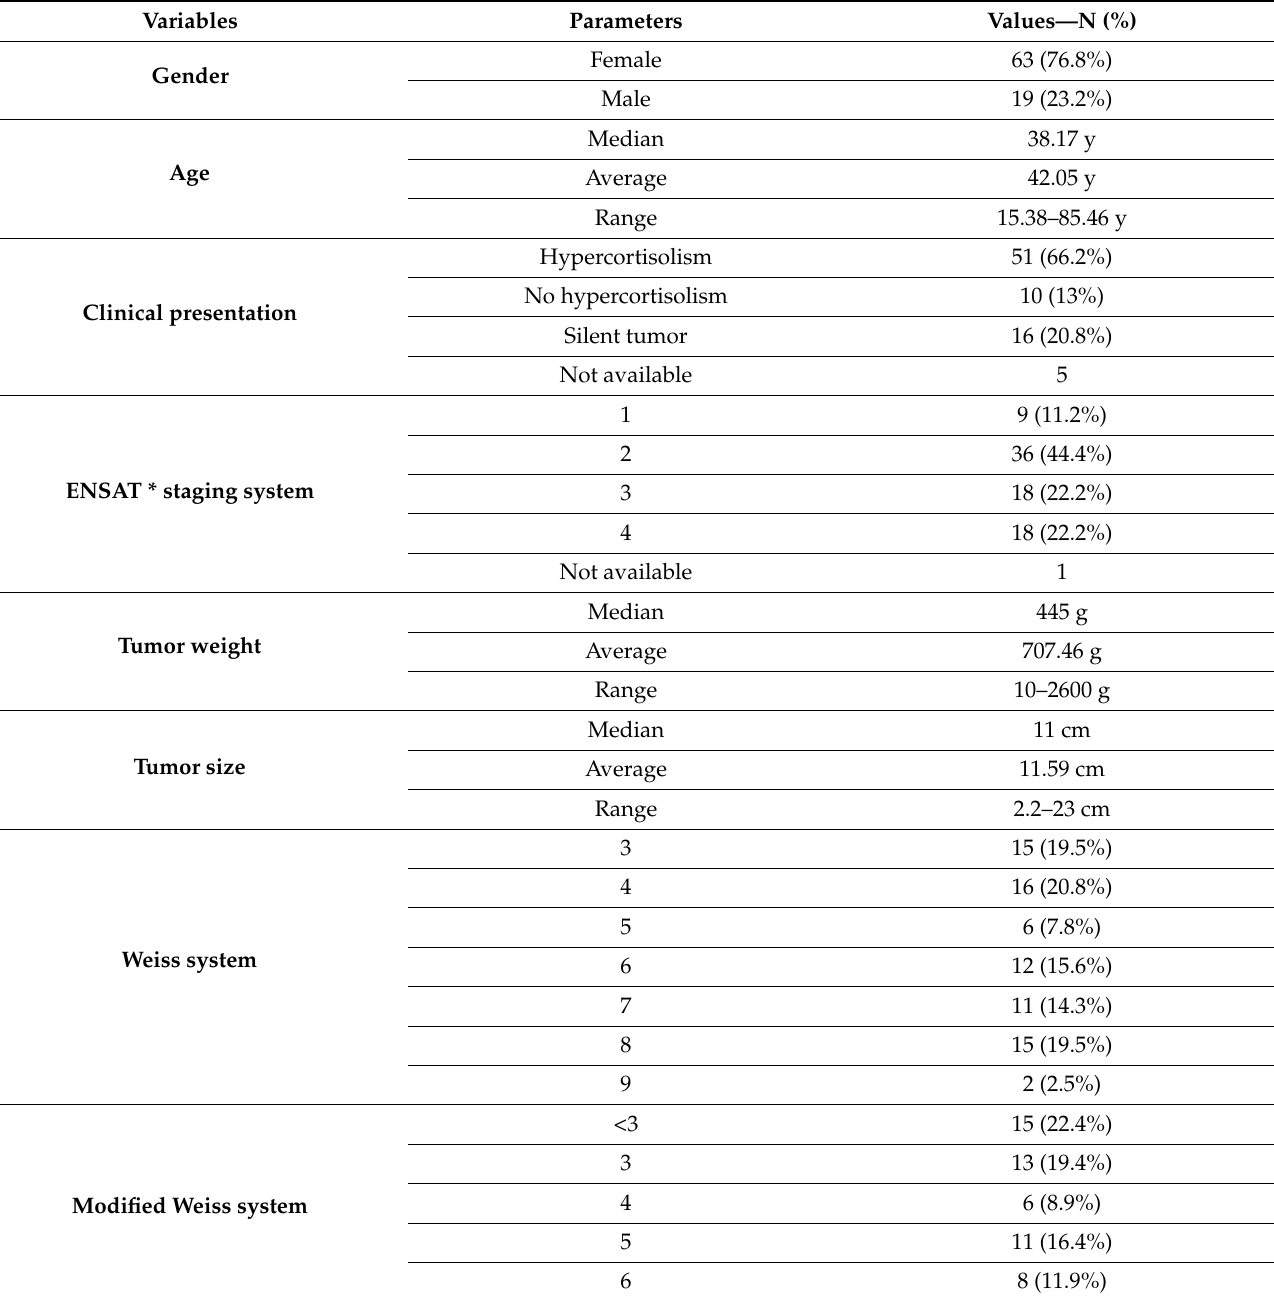
Table 1. Summary of features of 82 adult patients with adrenocortical carcinoma (ACC) which tumors were used on TMA.